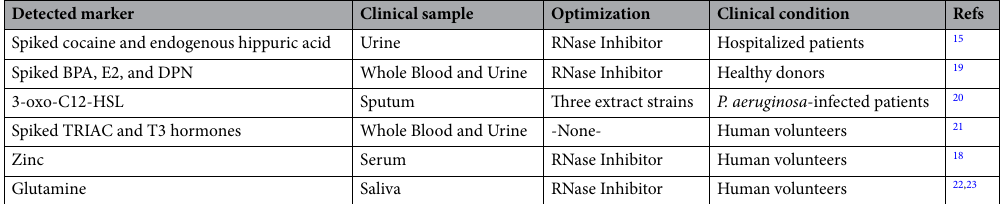
Table 1. Summary of previous cell-free biosensors testing in clinical samples, using E. coli